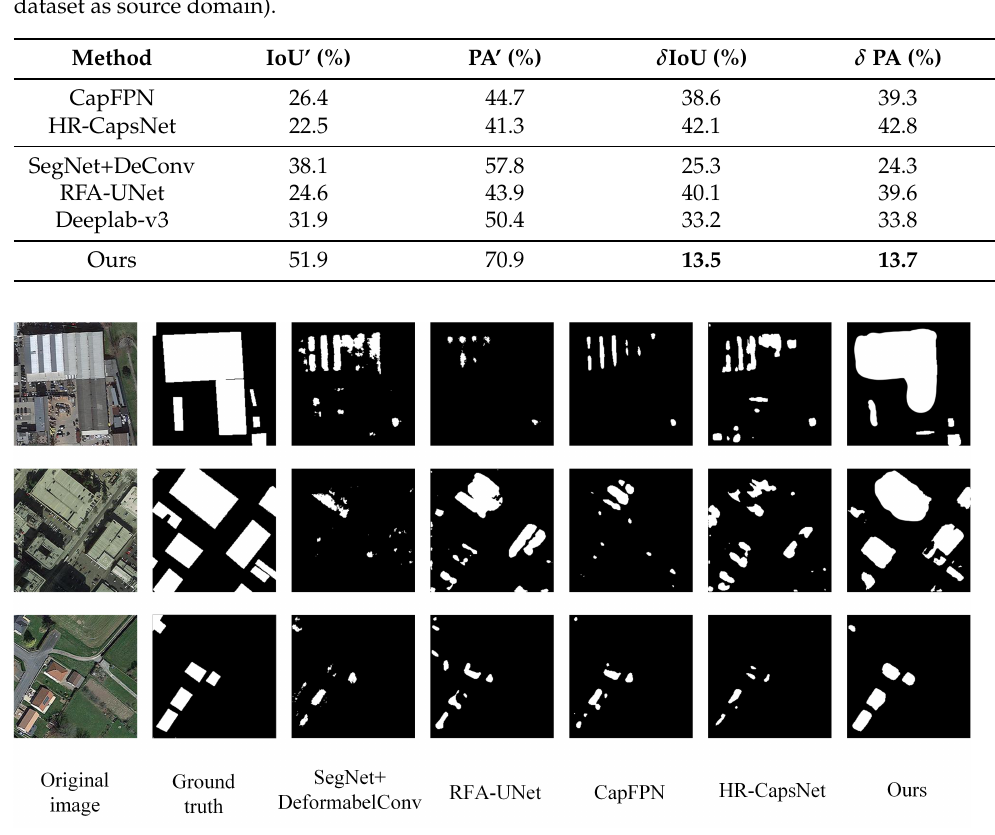
Figure 10. Comparison of the building extraction of different methods on the WHU dataset (Yellow River dataset as source